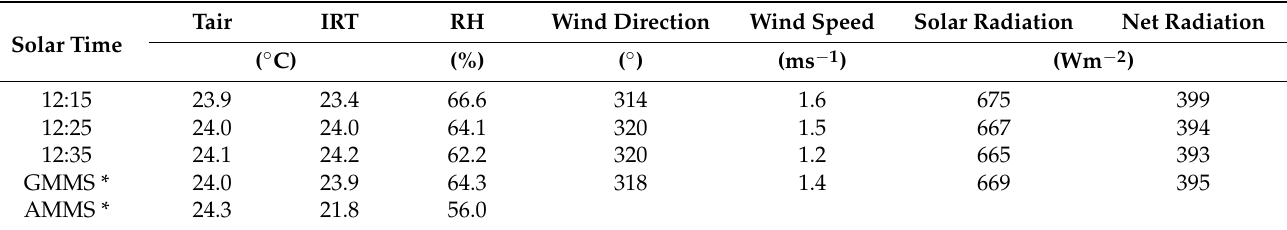
Table 1. Ten-minute average climatic data from the ground micrometeorological station (GMMS) from field 2 and the averages values from 217 measurements of the air temperature, canopy infrared temperature, and relative humidity from the aerial micrometeorological system